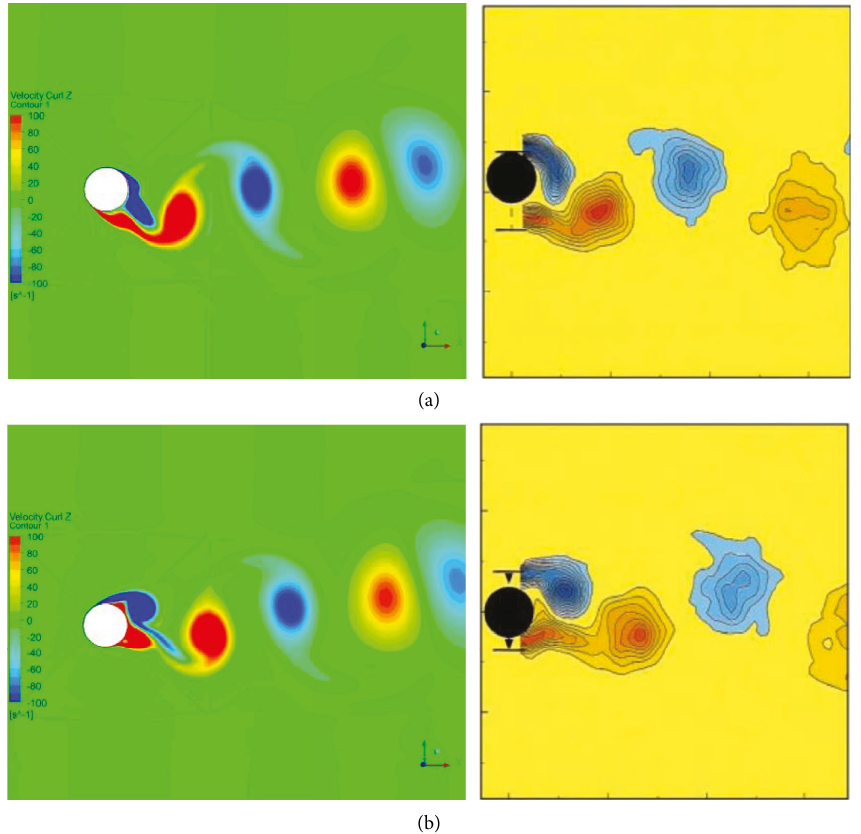
Figure 12: Initial branch showing 2S modes of numerical results at Ur � 2.67 with m ∗ � 2.4 and A ∗ � 0.12 (left) and PIV measurement results with � 8.63 and A ∗ � 0.33 by Govardhan and Williamson [26] (right): (a) cylinder highest position; (b) cylinder zero displacement position when traveling